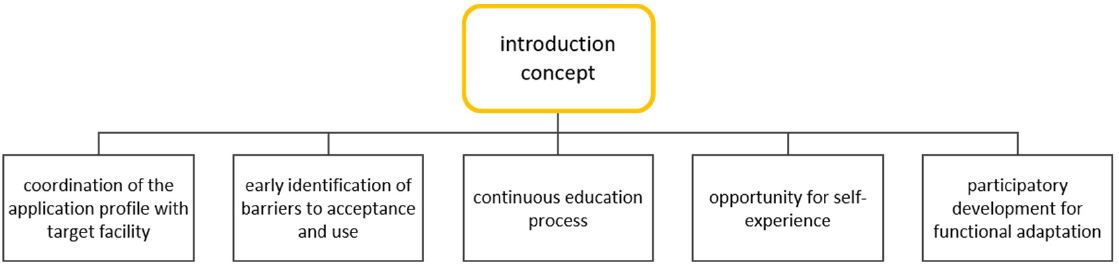
Figure 3. Requirements for the successful introduction of a robot in an inpatient care facility.